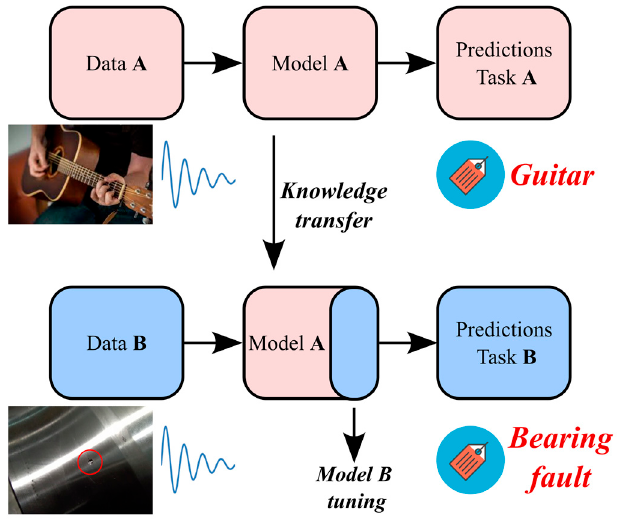
Figure 2. Knowledge transfer from an audio feature extractor to bearing health monitoring.